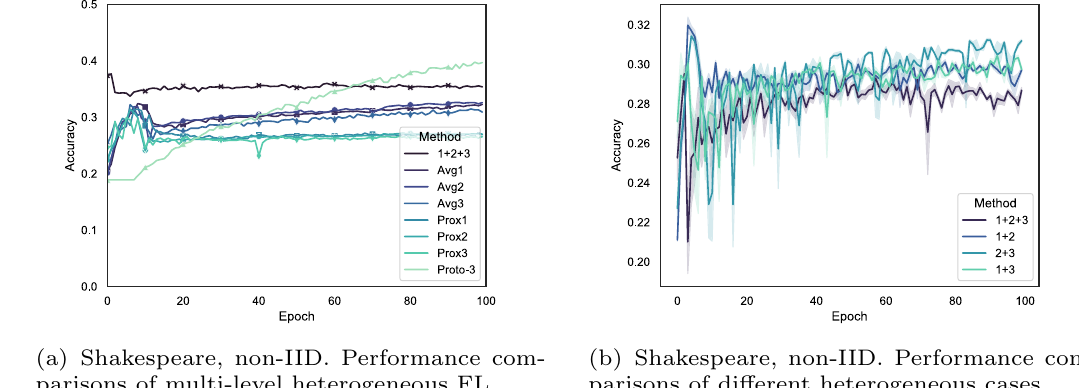
Fig. 8 Performance comparisons of multi-level heterogeneous FL (shown in a ) and performance comparisons of different heterogeneous cases (shown in b ) when the dataset is